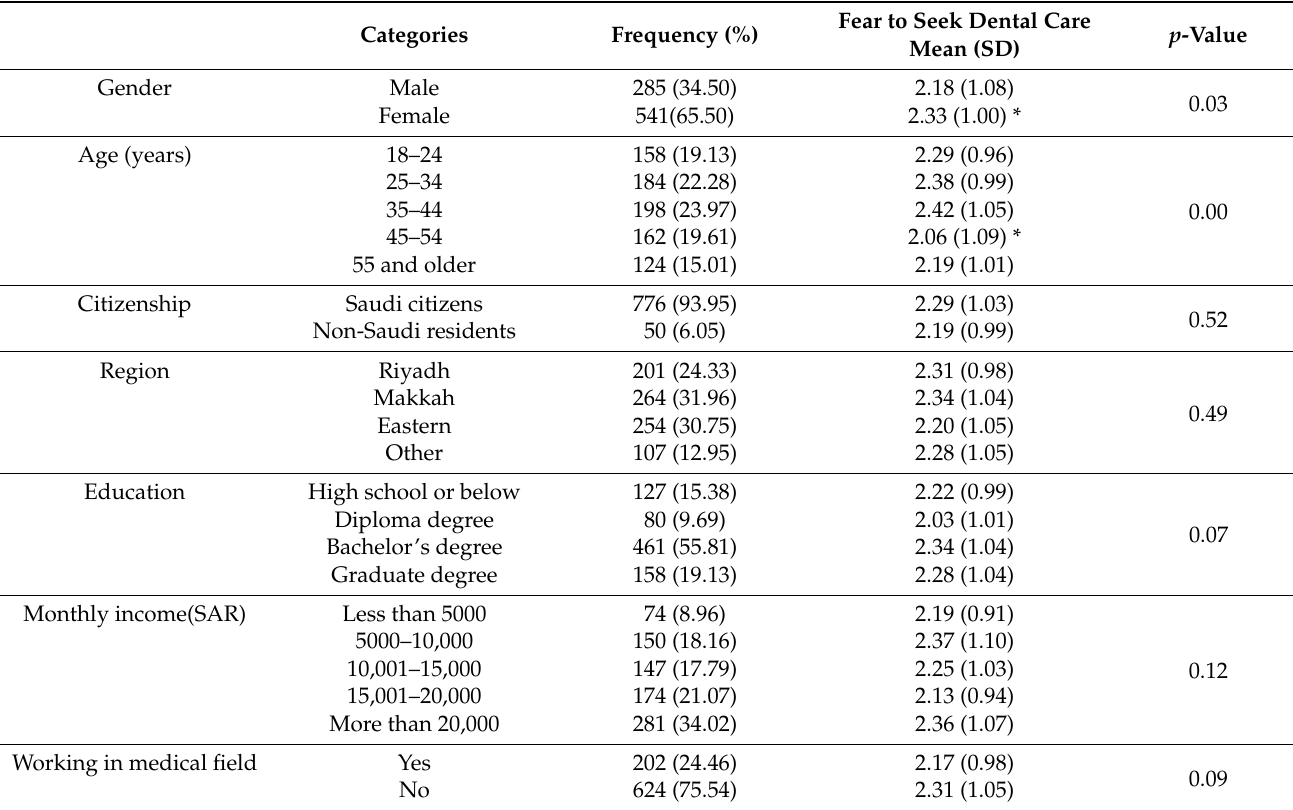
Table 1. Differences in fear to seek dental care by sociodemographic characteristics presented by means and standard